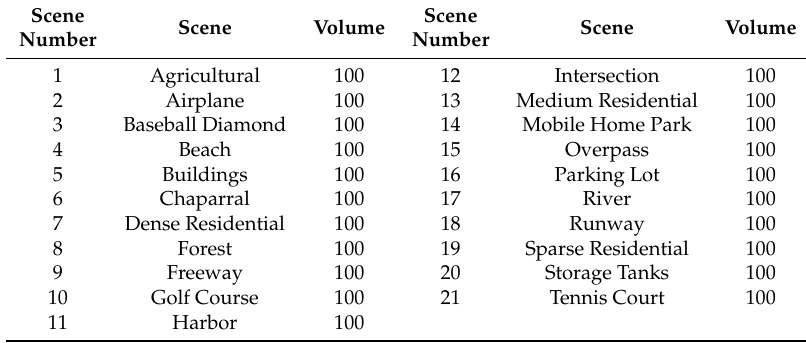
Table 1. Names and volume of different scenes in UCM dataset.